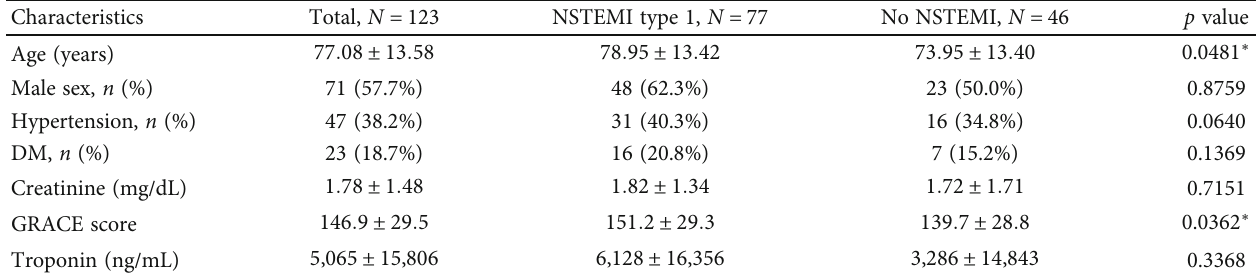
Table 1: Baseline characteristics of patients with sepsis who received a percutaneous coronary intervention. Characteristics